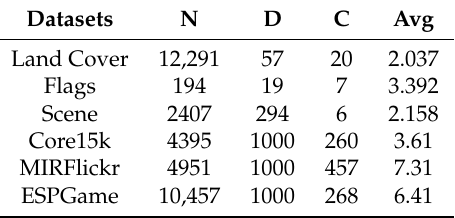
Table 2. Datasets used in the experiments. N is the number of images; D is the dimensionality of images; C is the number of distinct labels of images; Avg is the average number of labels per